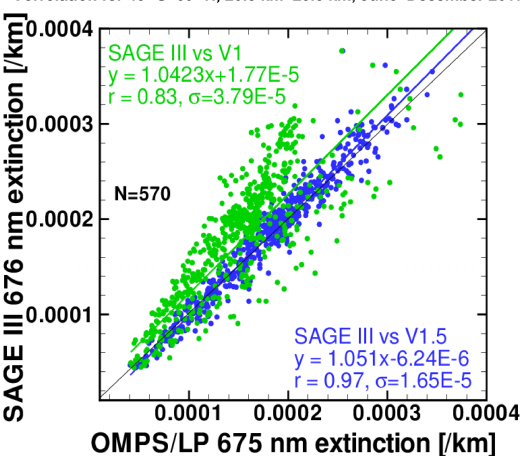
Figure 13. Correlation plot of SAGE III/ISS vs. OMPS/LP V1.5 (blue) and SAGE III/ISS vs. OMPS/LP V1.0 (green) zonal mean aerosol extinctions in 10 ◦ latitude bins from 45 ◦ S to 60 ◦ N between 20 and 25km for the entire comparison period. The blue and green lines show the linear regressions between the data points, and the thin black line represents a 1:1 relationship. The correlation coef- ficient r , the standard deviation of the differences ( x − y ) σ and the number of elements N used to compute r are also